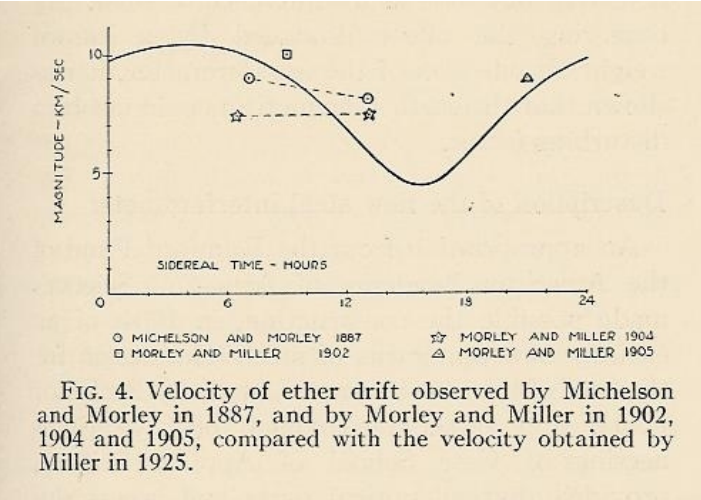
Figure 3. The observable velocity Equation (54) reported by Miller [59] various